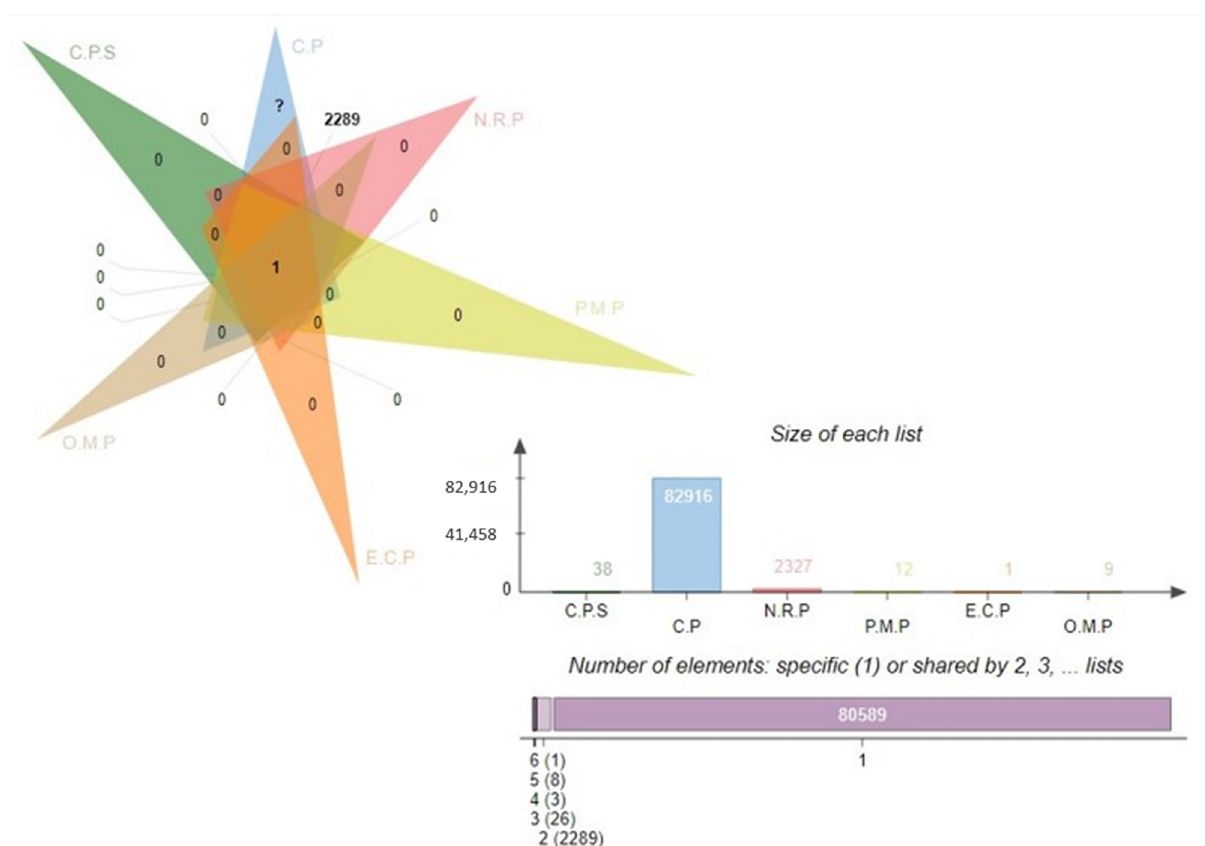
Figure 2. Venn analysis of the subtracted proteins in each subtractive filter. Complete proteome sequence, C.P.S; core proteome, C.P; non-redundant proteins, N.R.P; periplasmic membrane pro- teins, P.M.P; extra cellular proteins, E.C.P; outer-membrane proteins,